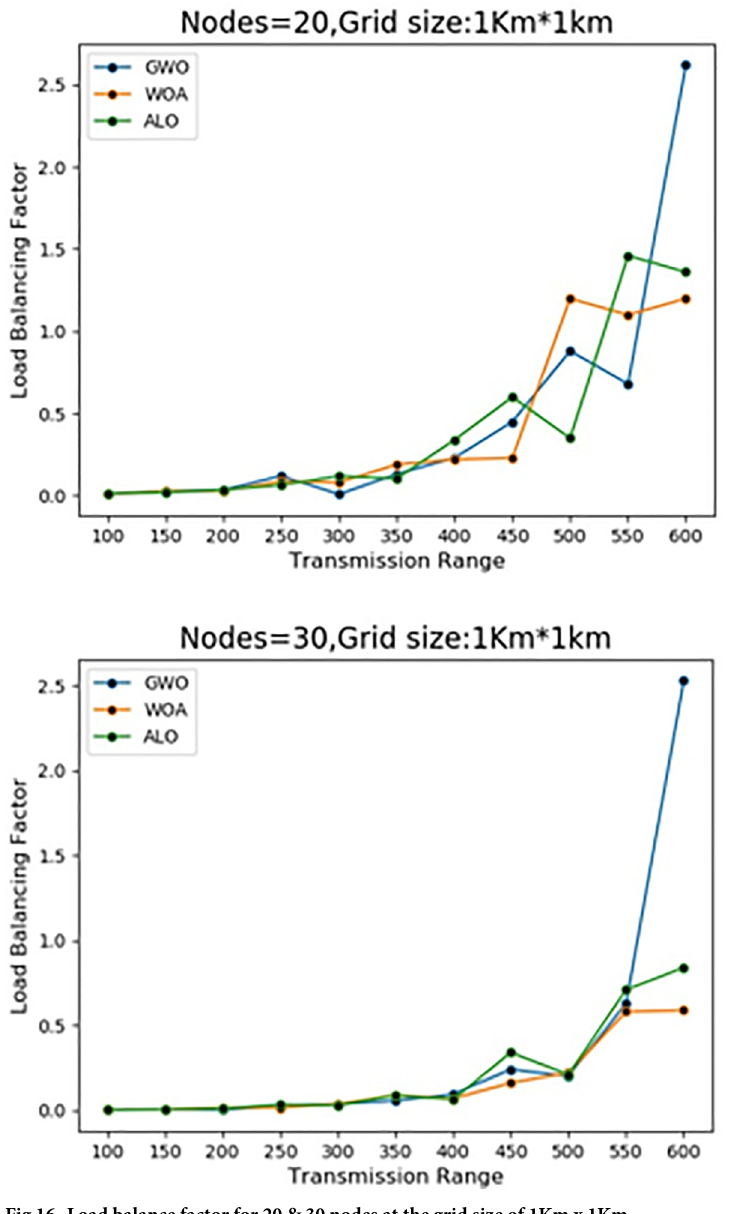
Fig 16. Load balance factor for 20 & 30 nodes at the grid size of 1Km x